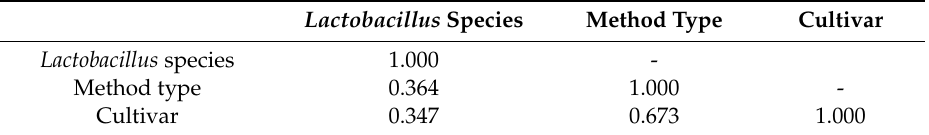
Table 5. Cramer’s V correlations matrix for the LAB, method type, and cultivar variables.